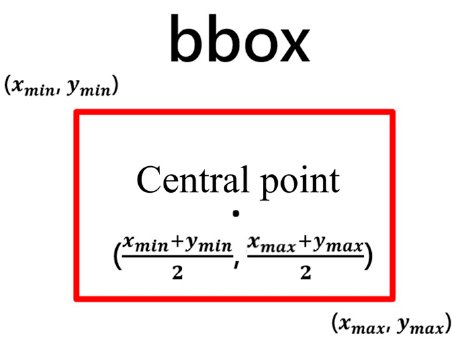
Figure 6. Illustration of center coordinates of the prediction box.